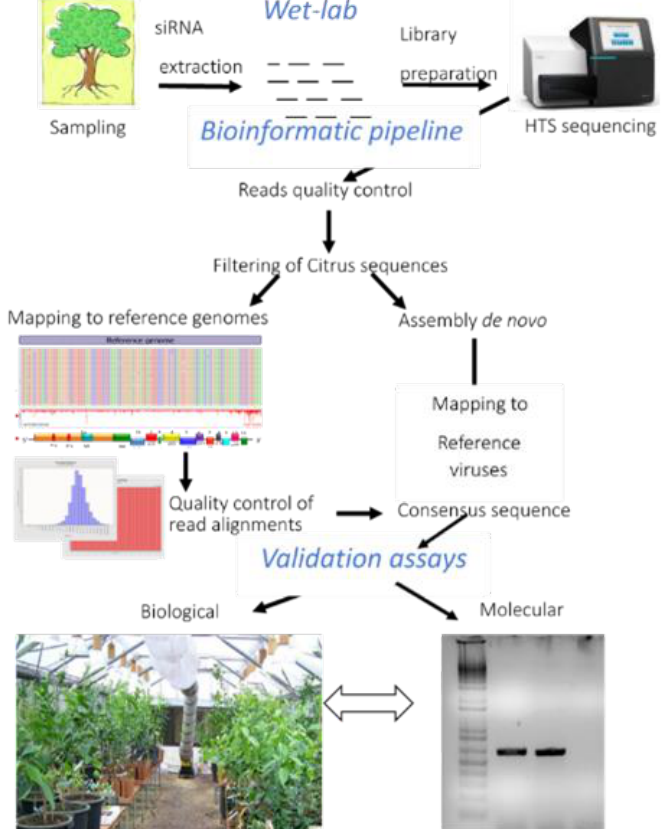
Figure 1. Schematic workflow of the procedure adopted for the detection of citrus viruses and viroids based on a multi-disciplinary approach in which HTS (including a wet-lab and a bioinformatic phase) is used as pre-screening analysis, whereas biological tests and molecular detection are used as validating assays. Table 1. Complete genome of citrus viruses sequenced by high throughput technologies.